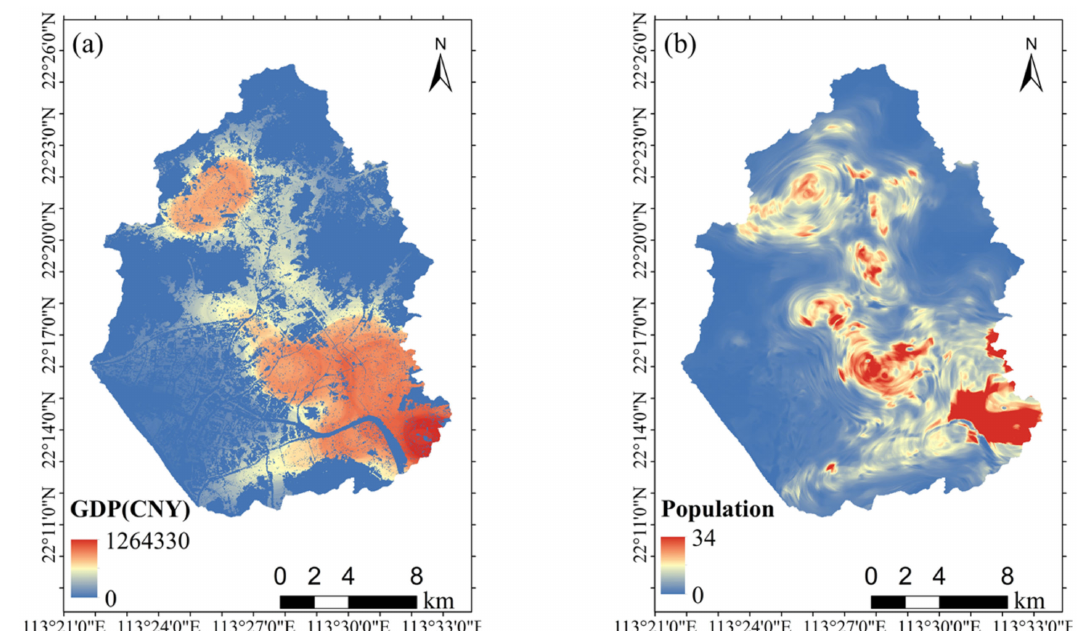
Figure 11. Spatial distribution of GDP and population in 2020 predicted by the random forest regression model. ( a ) GDP; ( b )